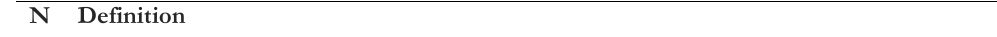
Table 1. The background of